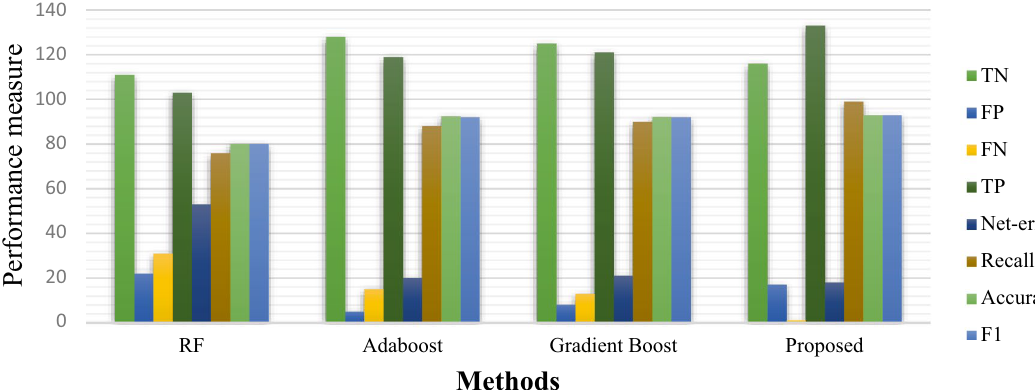
Figure 11. Comparison between state of the art ensemble methods.